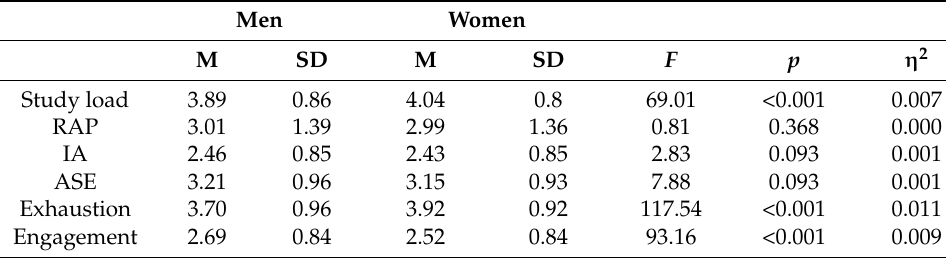
Table 5. ANOVA by gender.